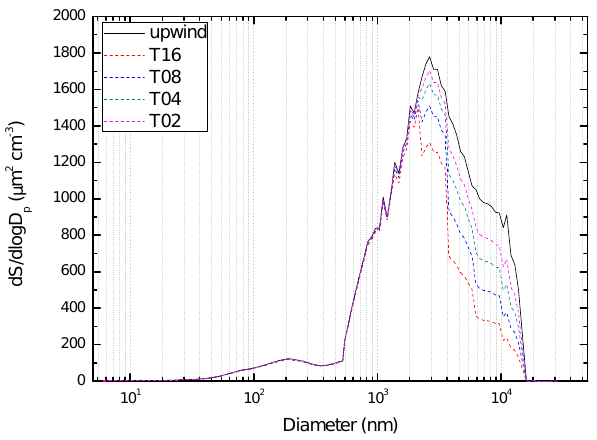
Fig. 2. Size distribution of dust surface area concentration in up- wind air mass and in the box, for the four exchange rates used in the